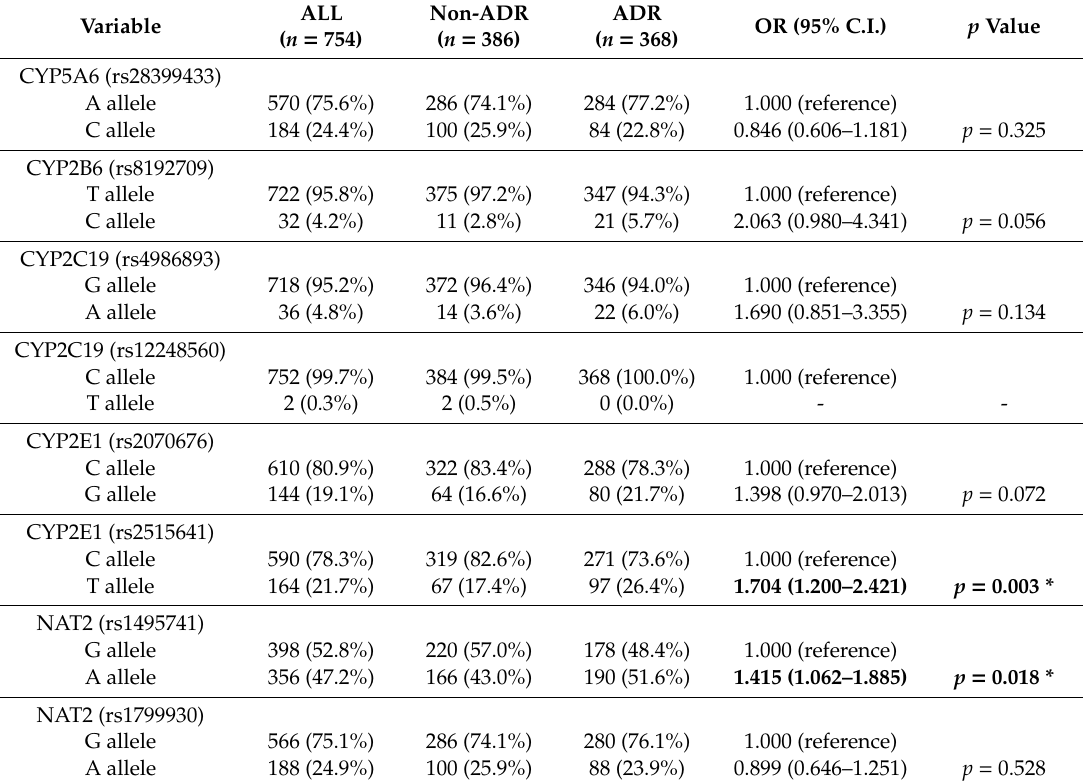
Table 4. Single nucleotide polymorphism frequencies of five drug-metabolic genes in 377